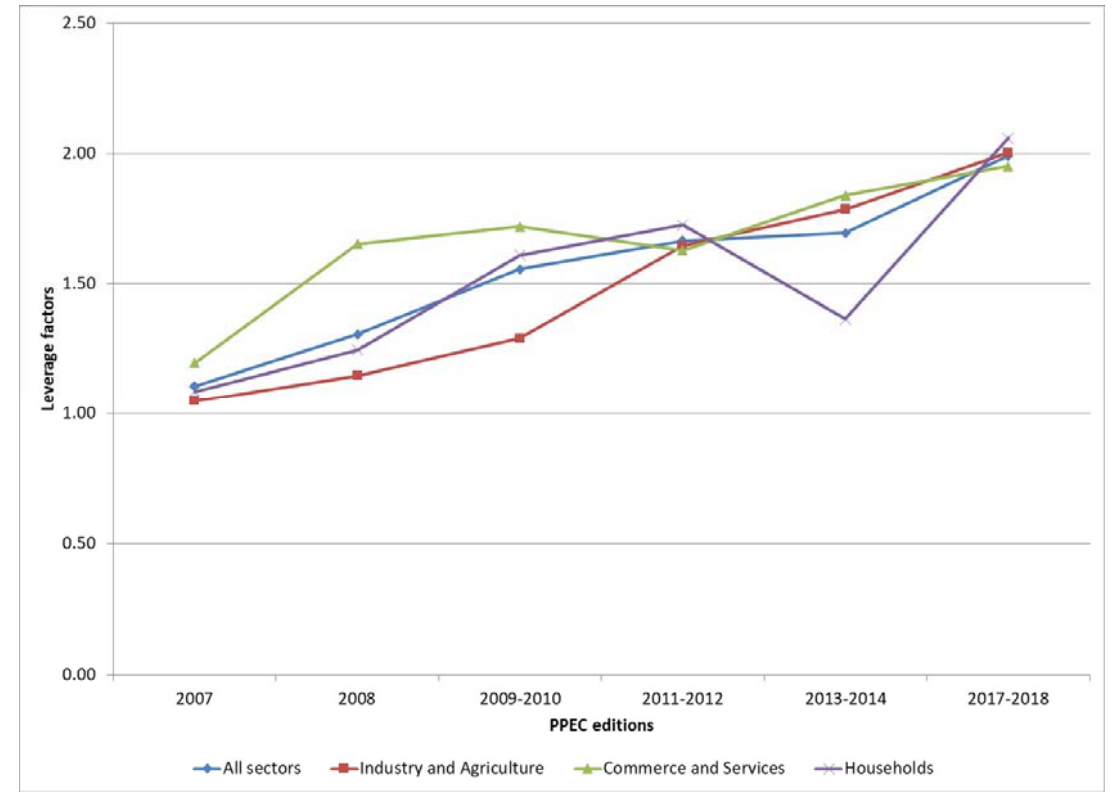
Figure 12. Leverage factors, for each PPEC edition, total and for each consumption segments [19–26].